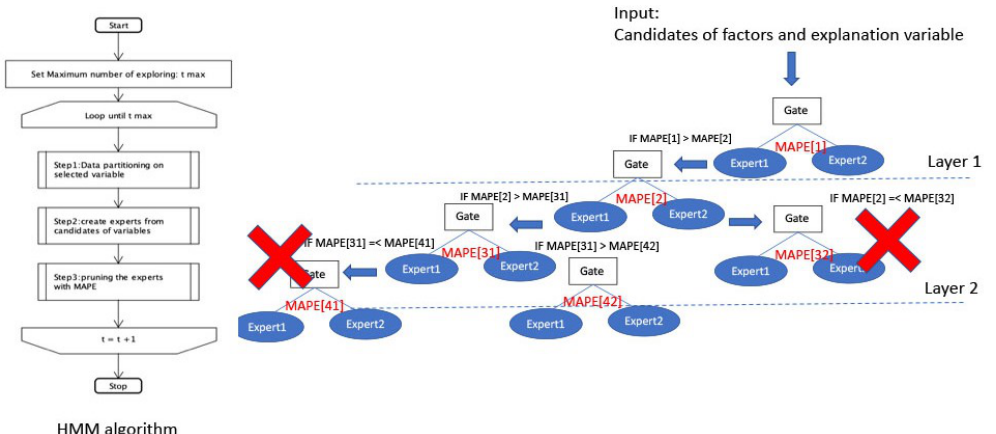
Figure 5. The algorithm for energy prediction tool on the HMM.